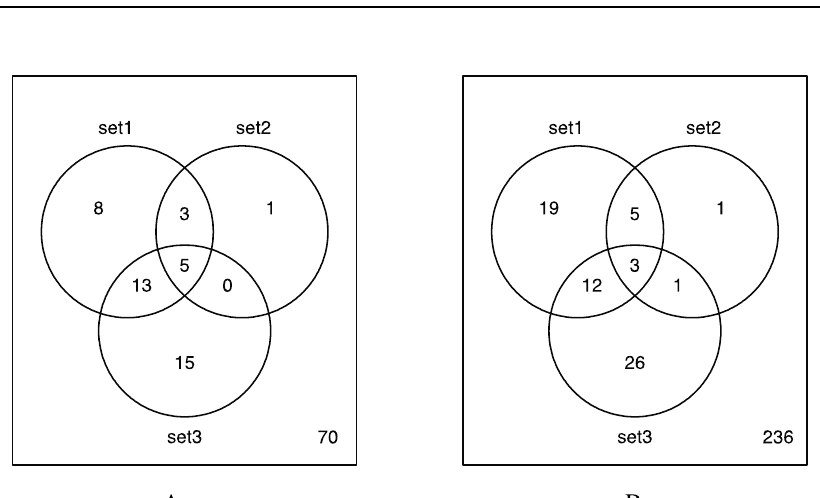
Figure 3. Venn diagrams of identified upregulated genes in TNF signaling pathway ( A ) and MAPK signaling pathway ( B ) that are shared between the three microarray datasets. Set1 corresponds to the human aortic endothelial cells, set2 corresponds to the lung-derived macrophages, and set3 corresponds to the A549 lung cancer